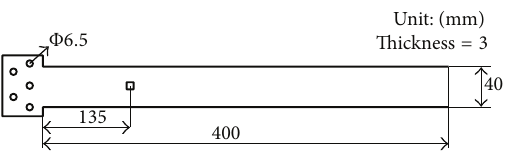
Figure 7: The dimension chart of the